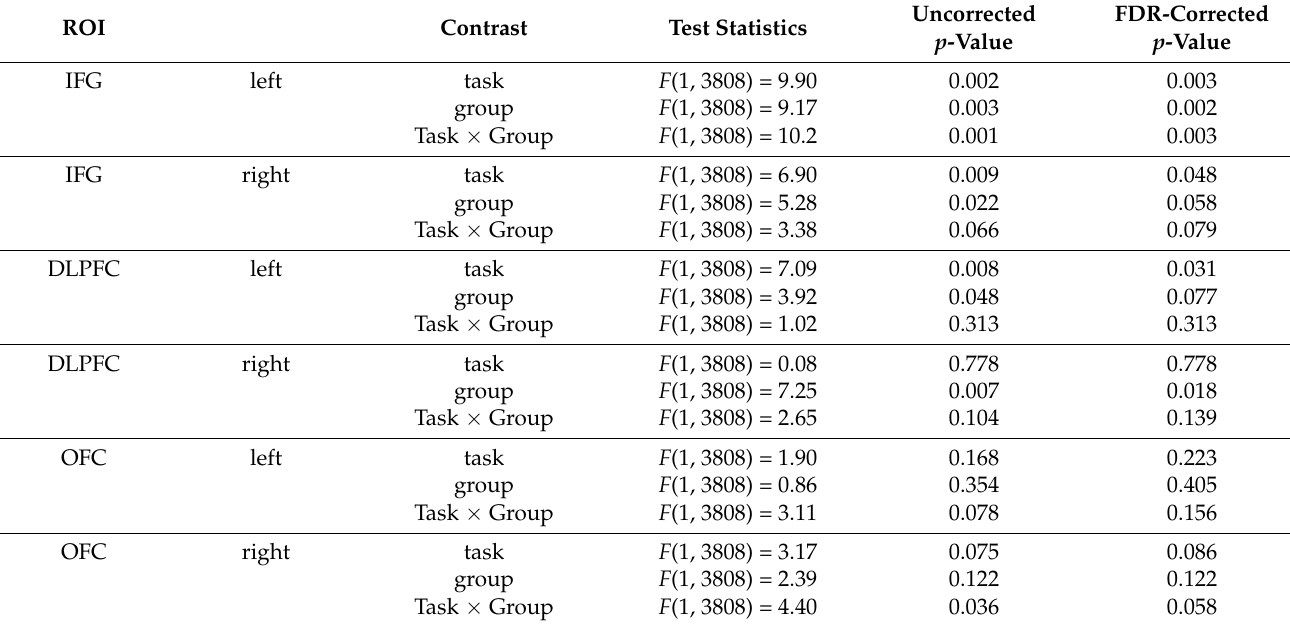
Table 2. Main effects of task, group, and the interaction on the fNIRS-based PFC responses. ROI Contrast Test